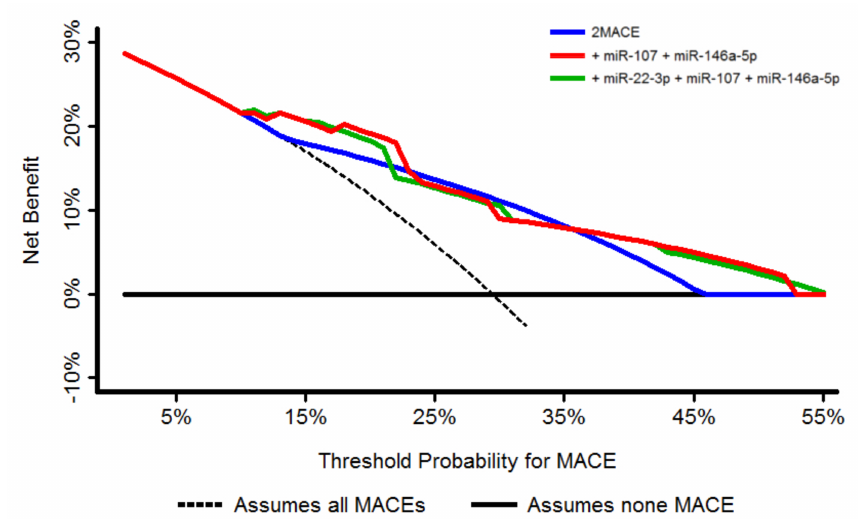
Figure 3. Decision curve analysis for the 2MACE score and the 2MACE models with the addition of miRNAs. MACE = major adverse cardiovascular